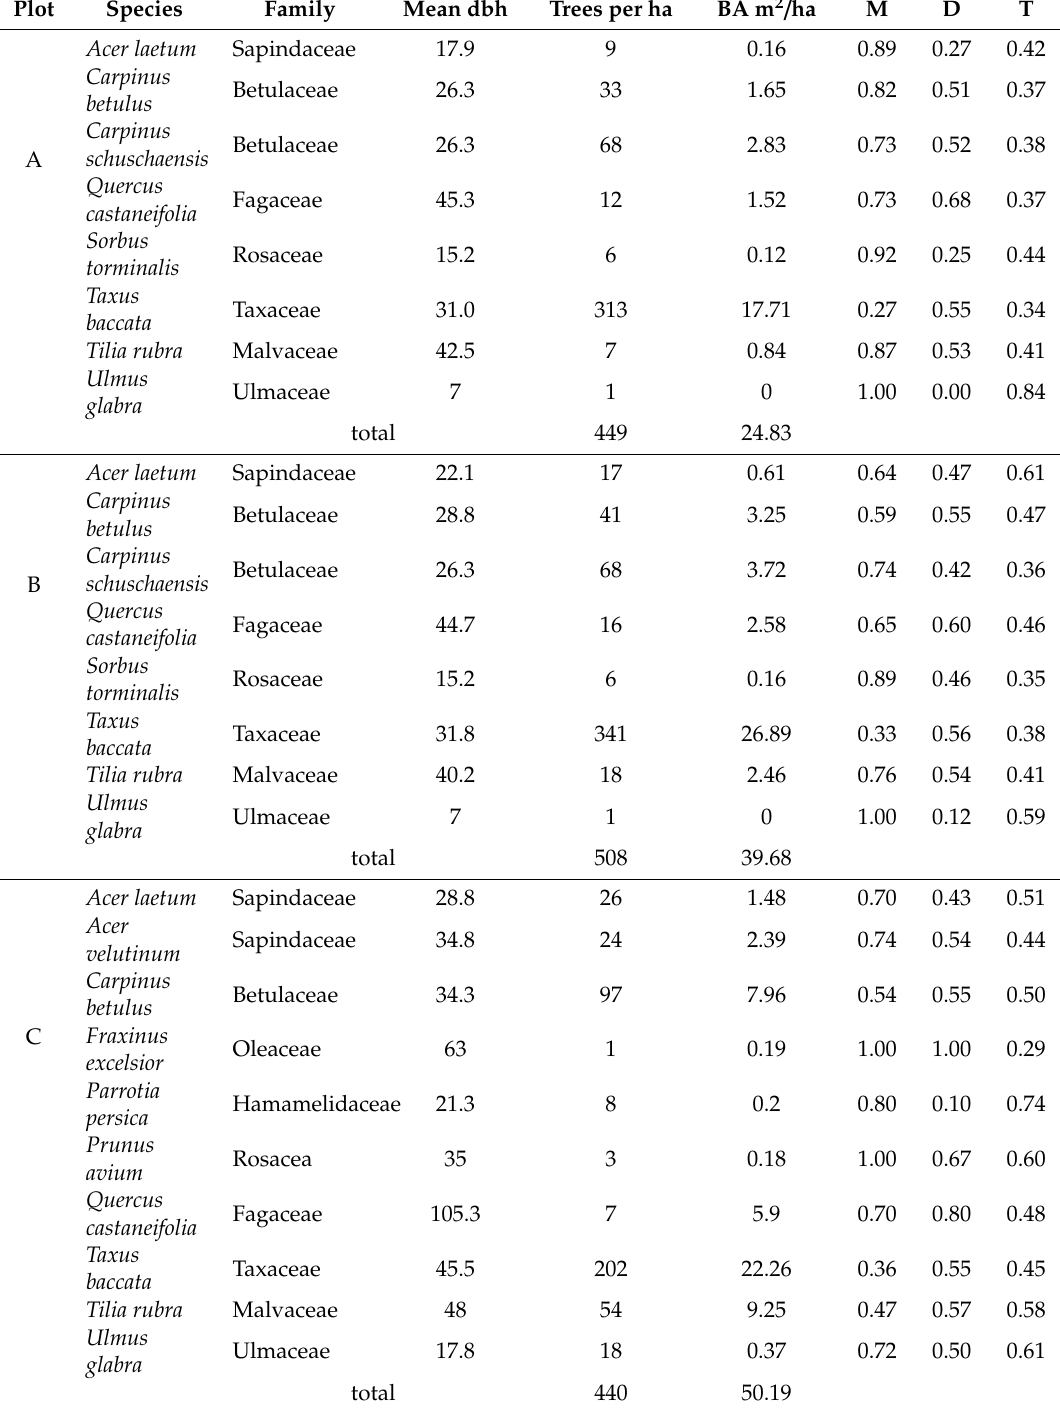
Table 4. Species-specific detail presented separately for each of the three field plots. Plot Species Family Mean dbh Trees per ha BA m 2 / ha M D